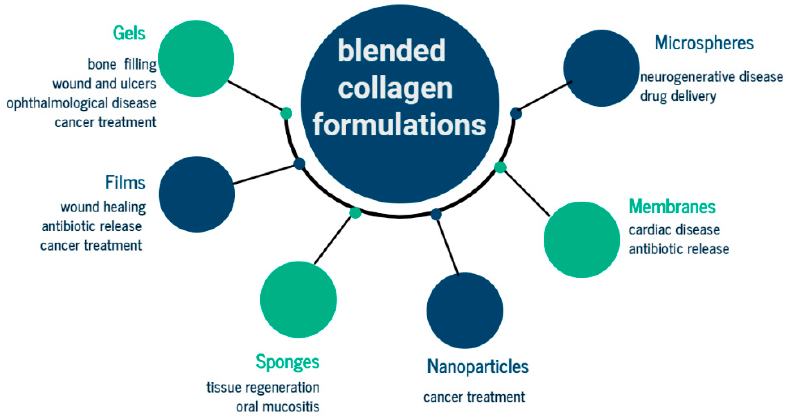
Figure 8. General biomedical application of drug delivery system based on blended collagen biomaterials.